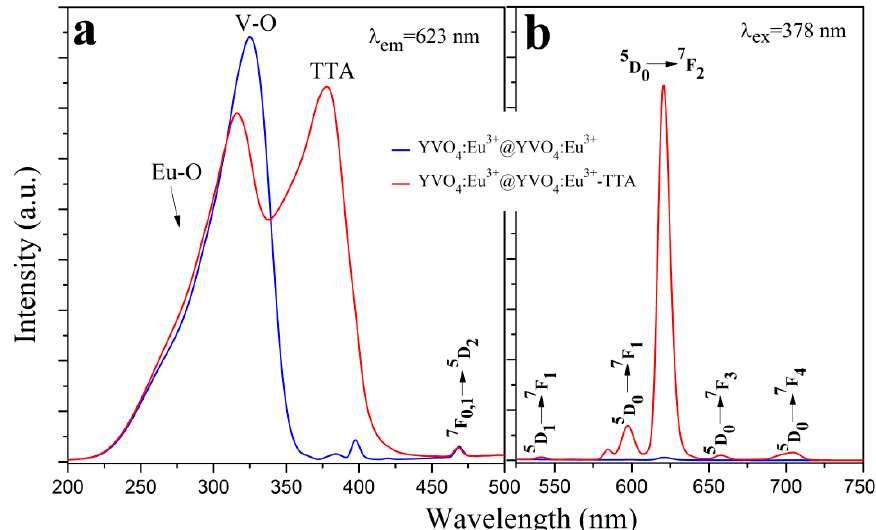
Figure 9. Comparison of the photoluminescence excitation ( a ) and emission ( b ) spectra of the YVO 4 :Eu 3+ @YVO 4 :Eu 3+ nanoparticles and the YVO 4 :Eu 3+ @YVO 4 :Eu 3+ –TTA inorganic–organic hybrid nanoparticles.